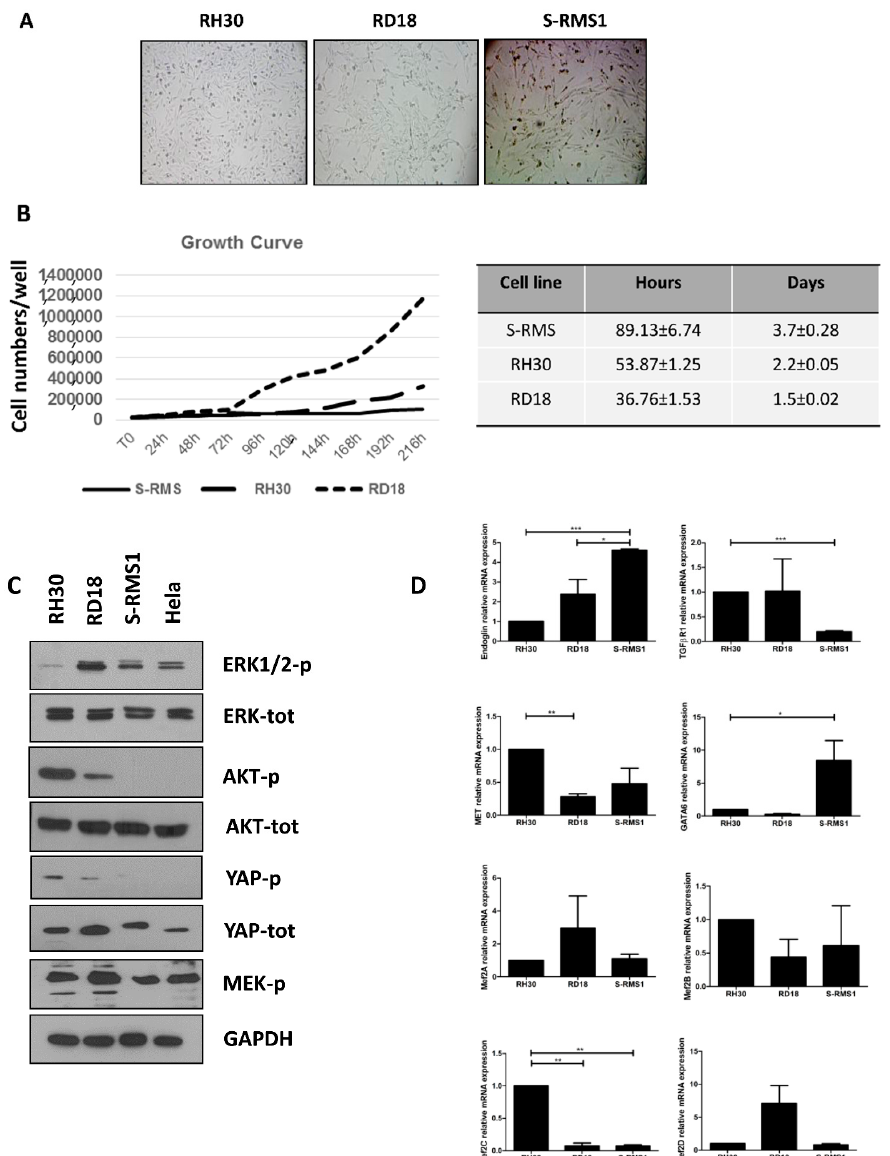
Figure 4. Characterization of S-RMS1 cell line. ( A ) Morphology of S-RMS1 compared with RH30 and RD18 cell lines (magnification 10 × ). ( B ) The population doubling time was calculated as reported and found to be of about 3.5 days for S-RMS1. ( C ) Western blot analysis of several pathways involved in rhabdomyosarcoma pathogenesis. ( D ) Real time qPCR of genes implicated in skeletal muscle differentiation (Mef2A, Mef2B, Mef2C, and Mef2D) and tumorigenesis (Endoglin, TGFß-RI, MET, and GATA6).